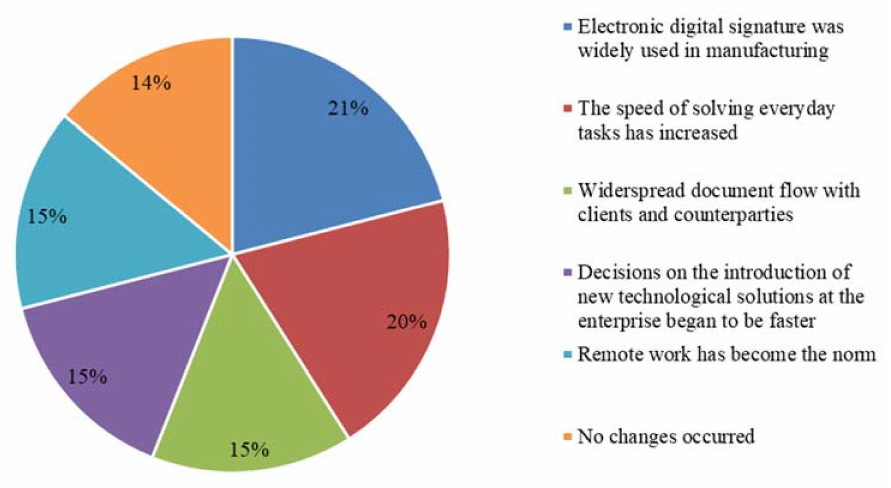
Figure 9. Modernization of business processes in production enterprises the Republic of